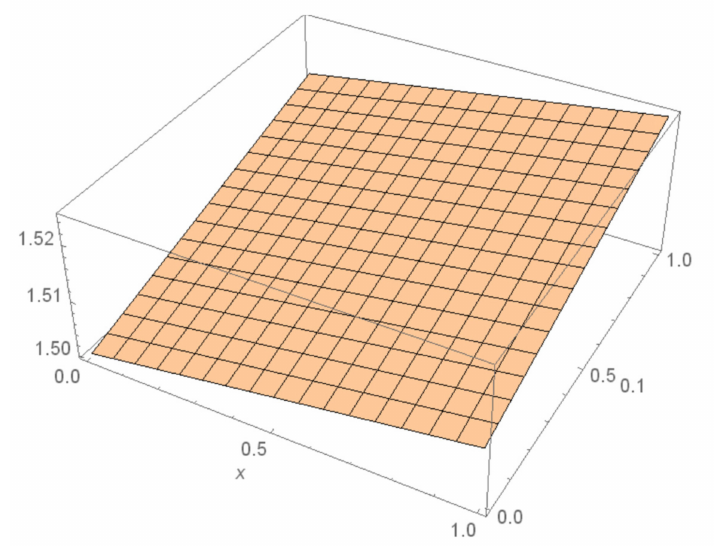
Figure 5. 3D plot of (cid:101) h ( η , t ) .